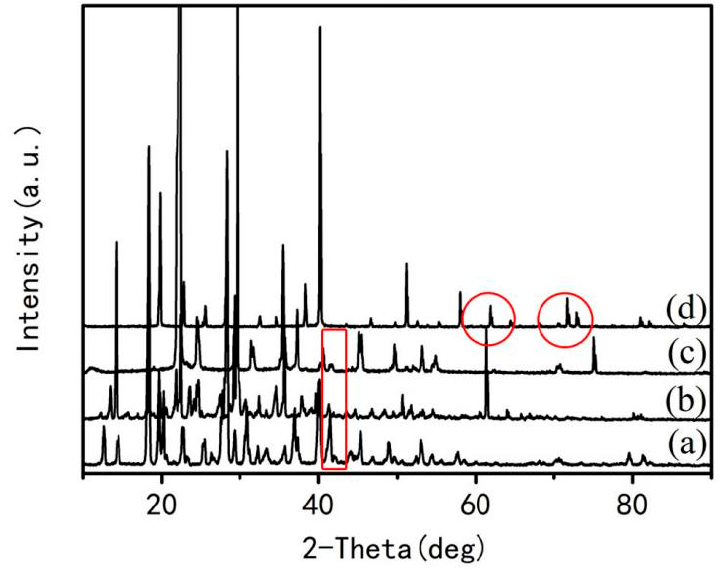
Figure 5. XRD spectra of the materials and gel: ( a ) glucose; ( b ) aluminum nitrate; ( c ) urea; ( d ) gel.